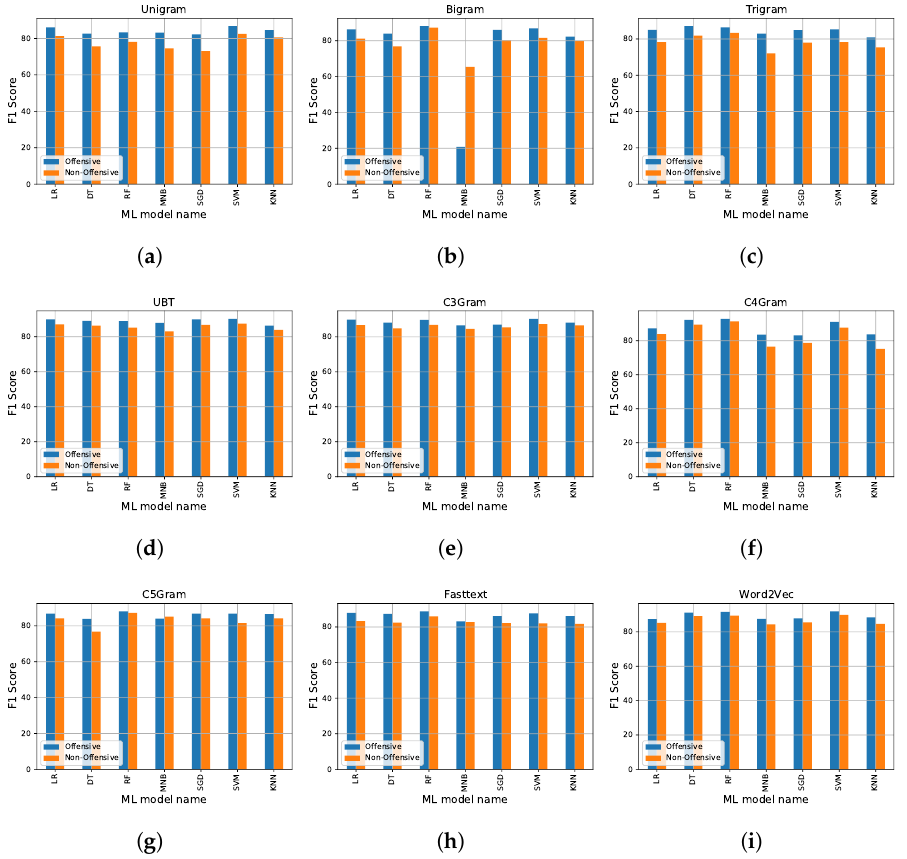
Figure 9. F1-score of various baseline methods on cross-validation